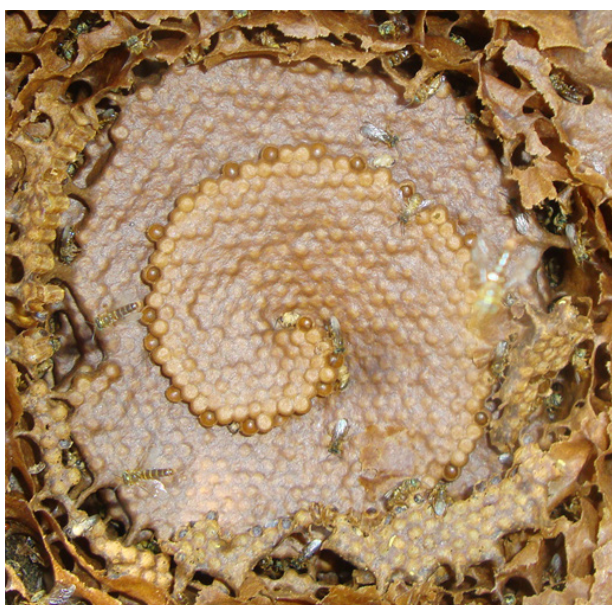
Fig 5 . Honey pots of Tetragona clavipes in a honey super. (Photo: